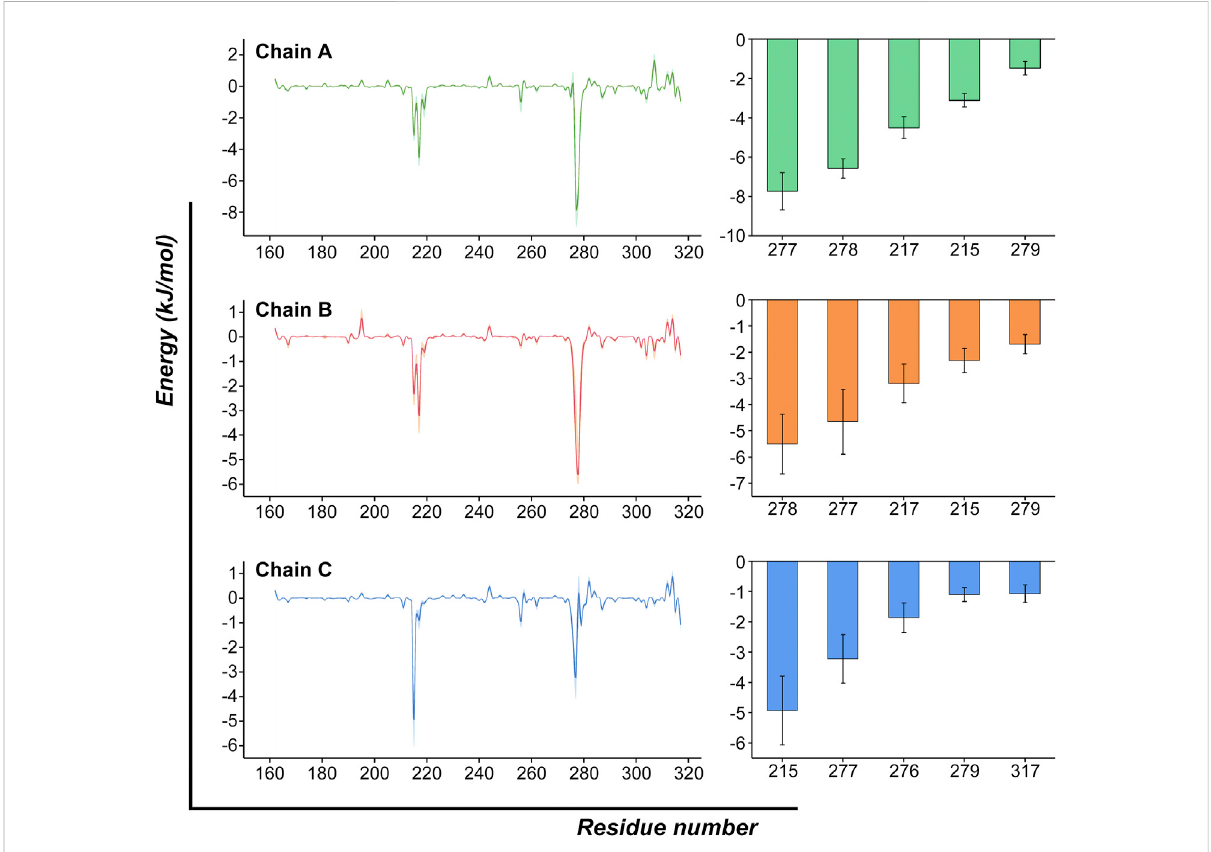
FIGURE 7 Per-residuebindingfree-energycalculation.Per-residuebindingfree-energycontributionspectraoftheinteractionbetweenRANKLandZOL. The bar graph on the right lists the top- fi ve residues of each chain and shows their energy contributions. (The results are presented as Mean ±